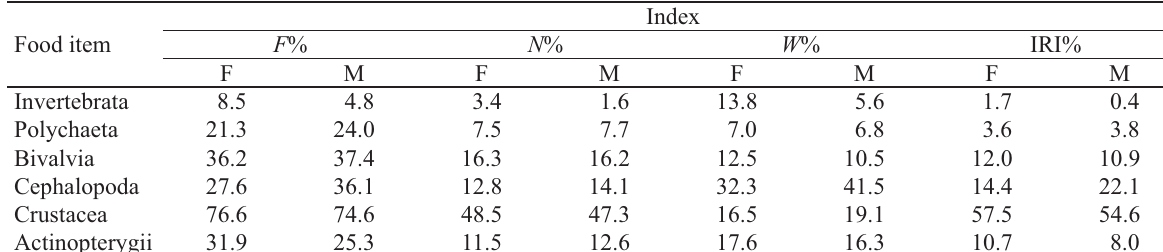
Major groups of food items found in the stomachs of female and male Mustelus